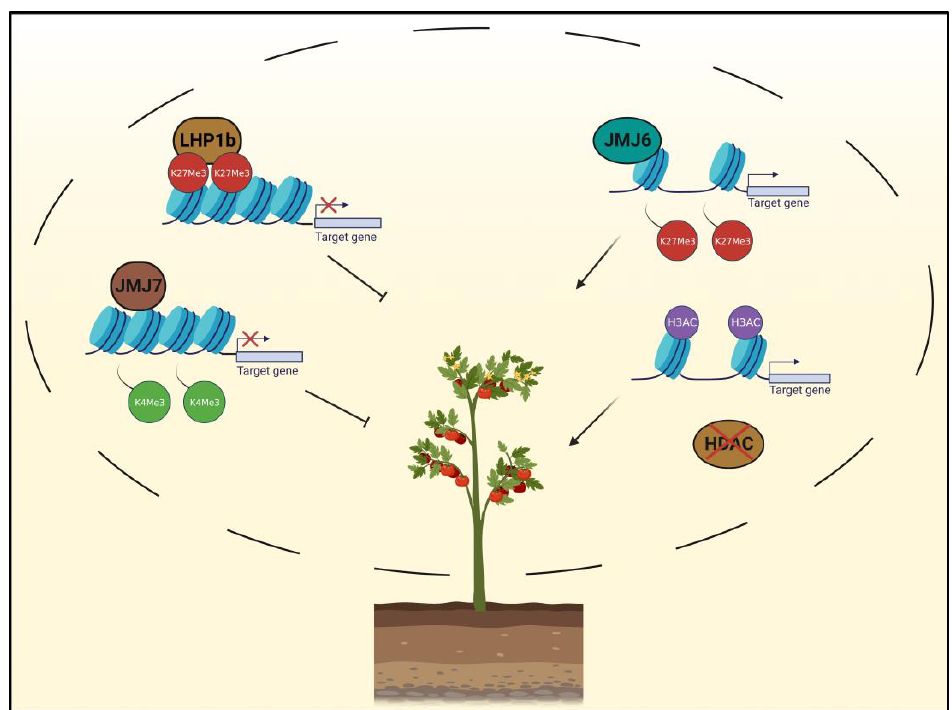
Figure 2. Tomato fruit ripening depends on chromatin positive and negative regulators of growth: LHP1b (Like Heterochromatin Protein 1b) delays fruit softening and ripening by accumulating H3K27me3 levels on target genes; histone demethylase JMJ (JUMONJI) 7 removes H3K4me3 markers on promoter regions, thereby reducing the expression of genes involved in ethylene biosynthesis. Conversely, JMJ6 reduces H3K27me3 levels on the same genes and induces their expression. Similarly, removal of histone deacetylases HDT1 promotes histone acetylation of genes involved in carotenoid accumulation and ethylene